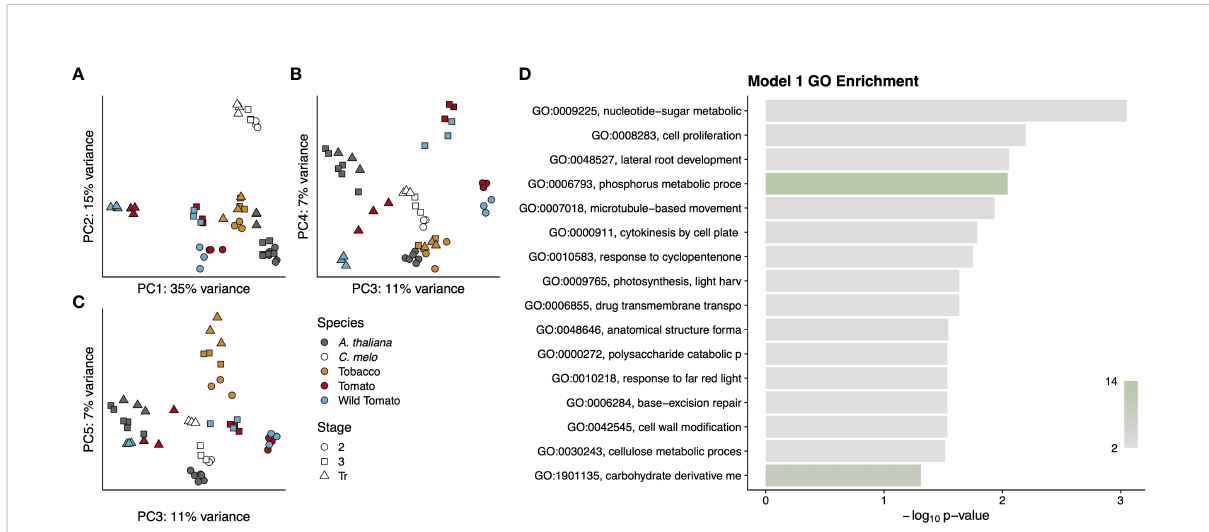
FIGURE 7 Summary of genes from Model 1. Principal components analysis (A – C) of gene expression values for each RNA-seq library. Points are colored by species and shaped by developmental stage as indicated in the legend. Principal components used for each graph are indicated on the axis along with the proportion of variance explained. A GO analysis (D) for the entire cohort of genes. GO term names to the left of the graph are truncated to available space. Terms are sorted by p-value, which is indicated by the bar height. Bars are colored by the number of genes annotated to that term, as indicated by the colour scale in the lower